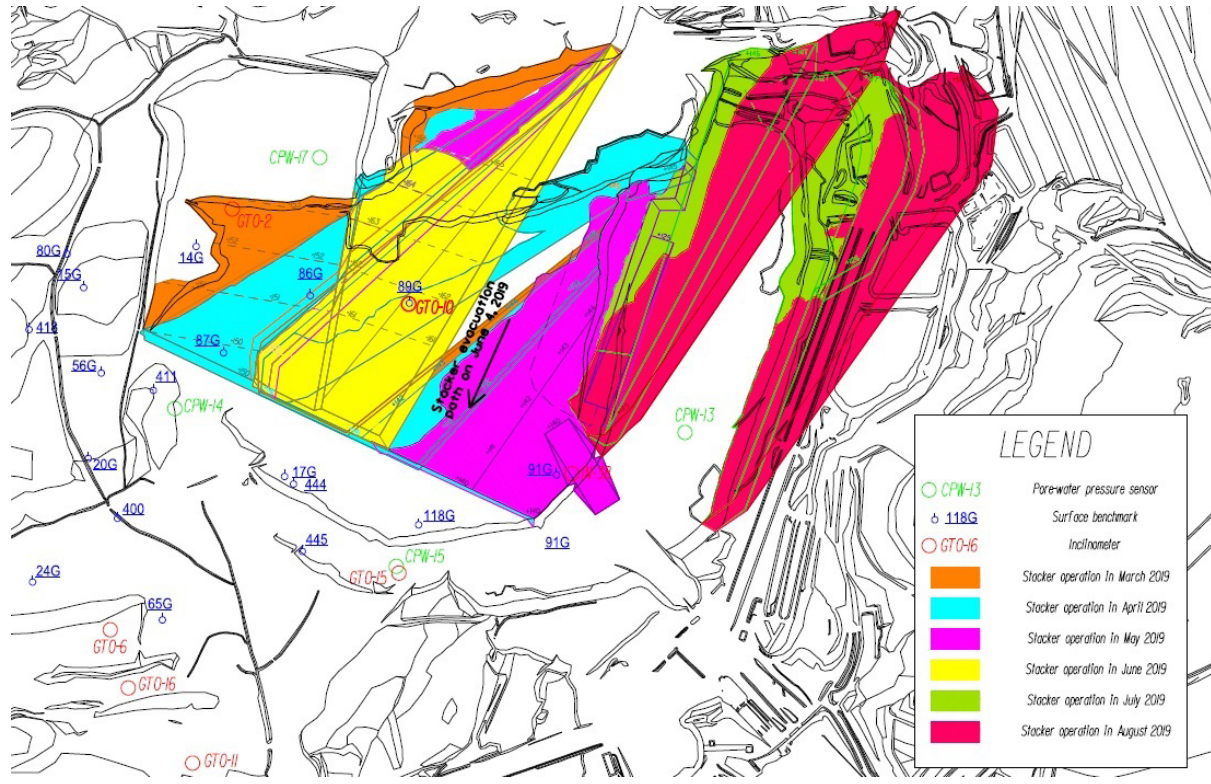
Figure 3: Operating area of stacker Z-48 with inclinometer